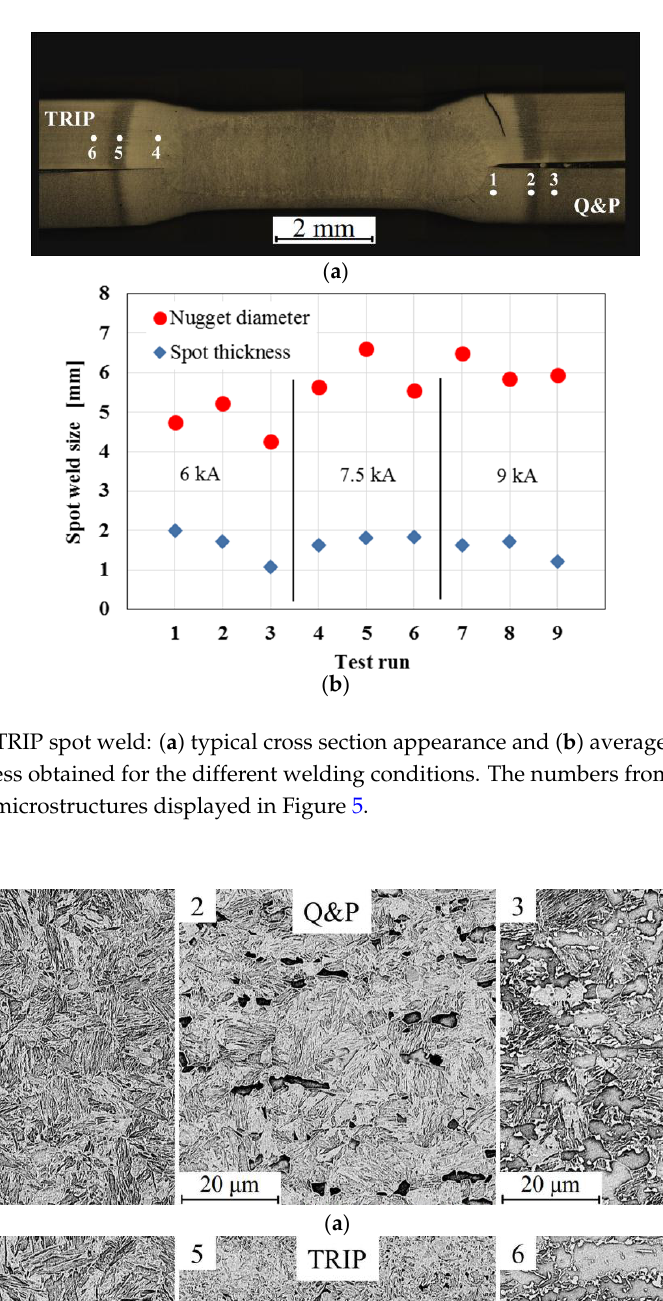
Figure 4. Q&P/TRIP spot weld: ( a ) typical cross section appearance and ( b ) average nugget diameter and joint thickness obtained for the different welding conditions. The numbers from 1 to 6 define the locations of the microstructures displayed in Figure 5.